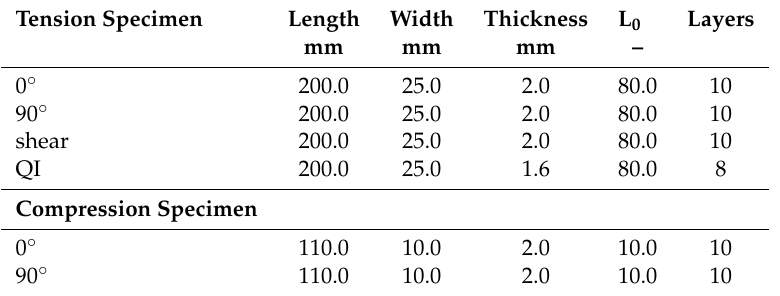
Table 1. Dimensions of the testing specimens in mm. L 0 denotes gauge length. For tensile testing, specimen sizes are according to ASTM D 3039 and for compressive testing based on ISO 14126. Tension Specimen Length Width Thickness L